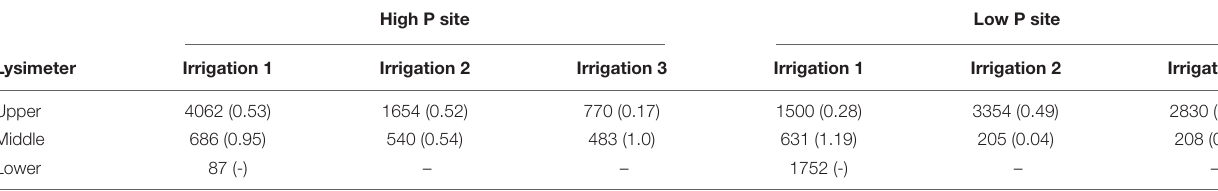
TABLE 5 | Mean cumulative TP loads (in µ g m − 2 ) per irrigation, in brackets their coefficient of variation (CV) ( − ).